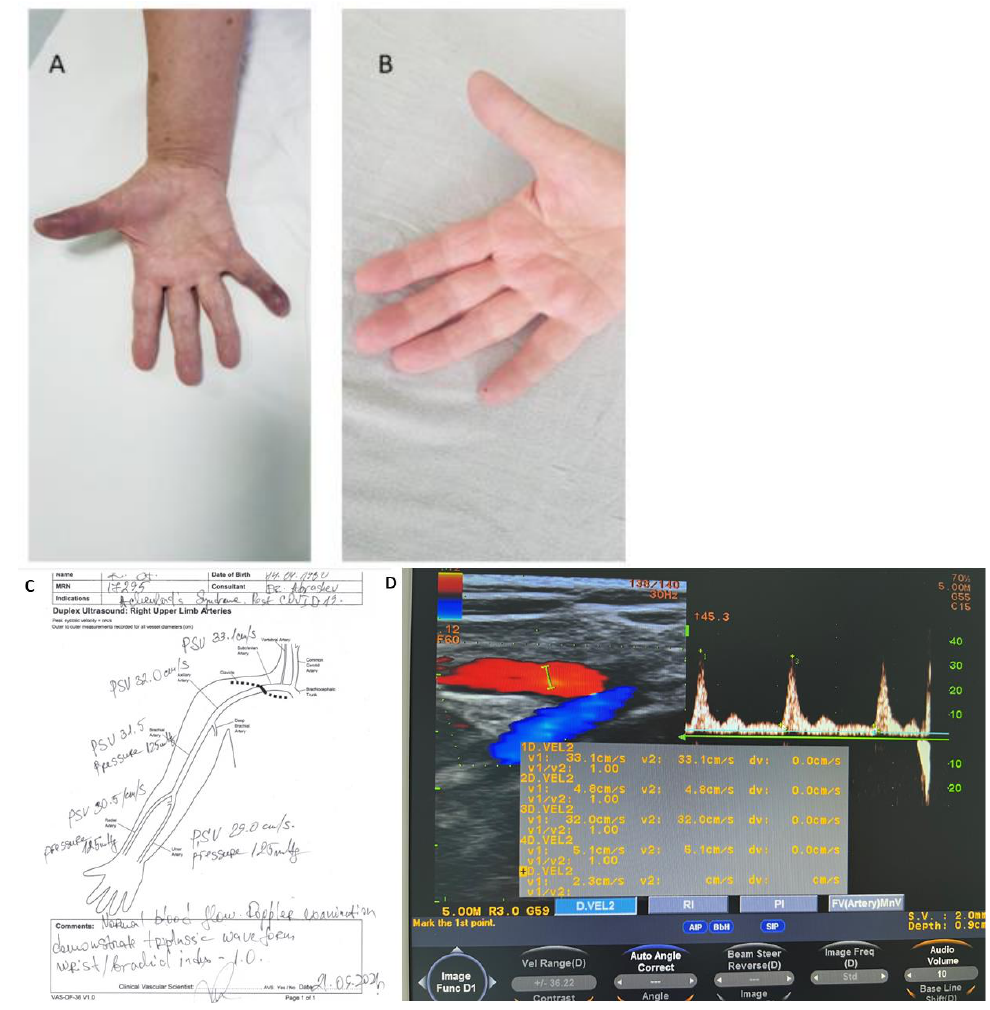
Figure 2. ( A , B) . A 71-year-old non-smoking woman presented with sudden swelling and bruising along the volar aspect of her first and fifth fingers on her right hand. Hand pictures: ( A ) the first day of admission; and ( B ) the first day of discharge. ( C , D ). Data of Doppler investigation ( C ) and Doppler ultrasound result ( D ) showed normal peak forward velocities in cm/s. Doppler examination demonstrates triphasic waveforms. Brachial/wrist index of 1.0.